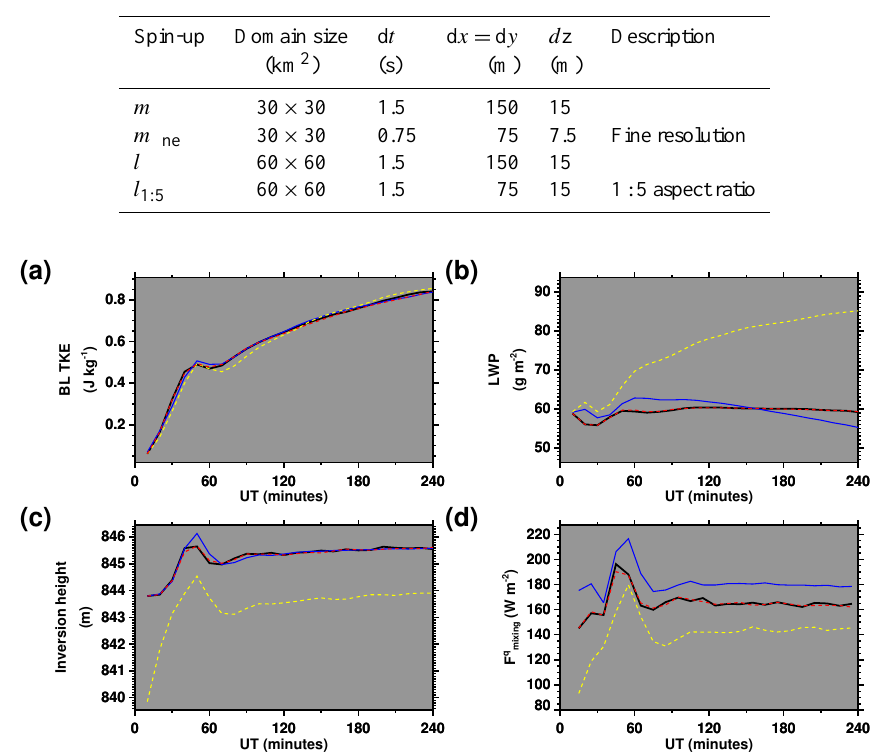
Table 1. List of spin-up runs.